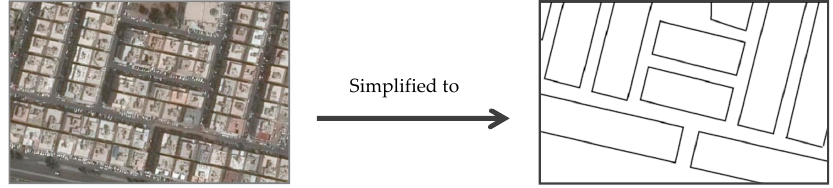
Figure 3. Simplification of the number of buildings: the left figure is a real aerial photo of parcels of multistory houses; the right figure shows treating each parcel as one building.